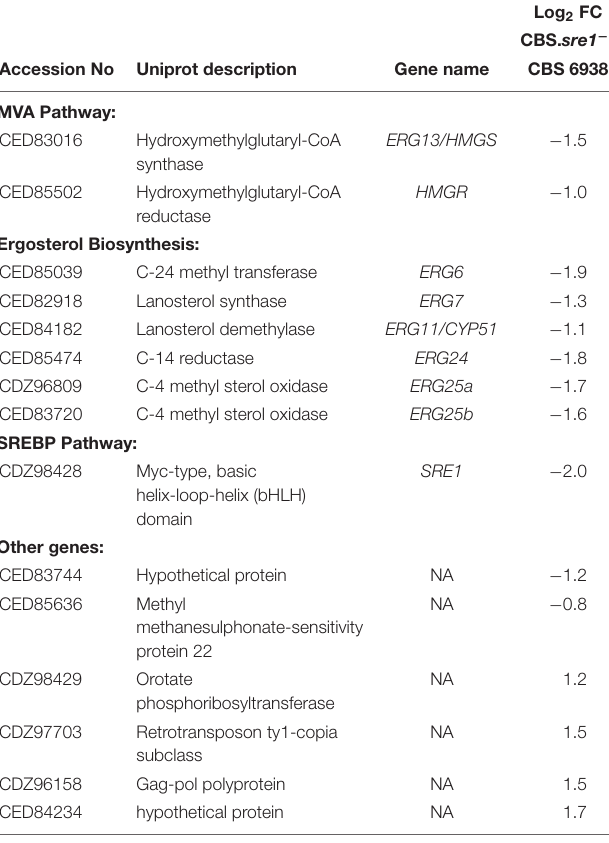
TABLE 3 | Differentially expressed genes (DEGs) between strains CBS. sre1 − and the wild-type (CBS 6938) using the DESeq2 tool, adjusted p -values ≤